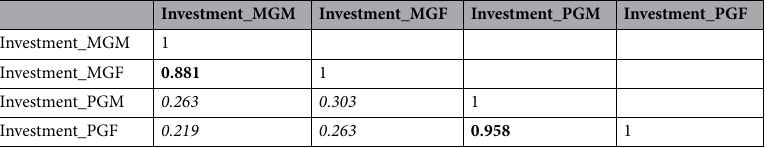
Table 2. Correlation matrix of latent variables representing grandparental investment in grandchildren. Cells filled in with bold and italics denote within- and between-lineage correlations of grandparental investment, respectively. The suffixes _MGM, _MGF, _PGM and _PGF denote maternal grandmother, maternal grandfather, paternal grandmother, and paternal grandfather, respectively.